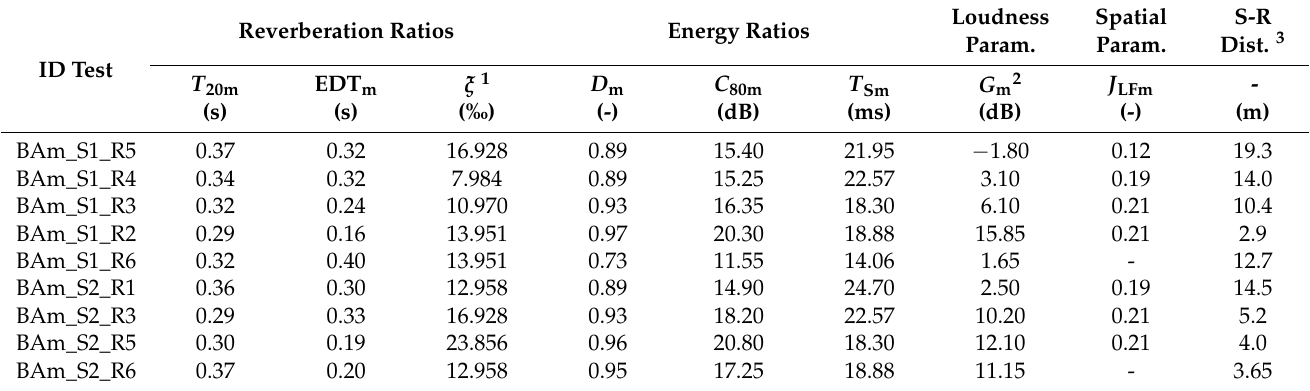
Loudness Spatial S-R Param. Param. Dist. 3